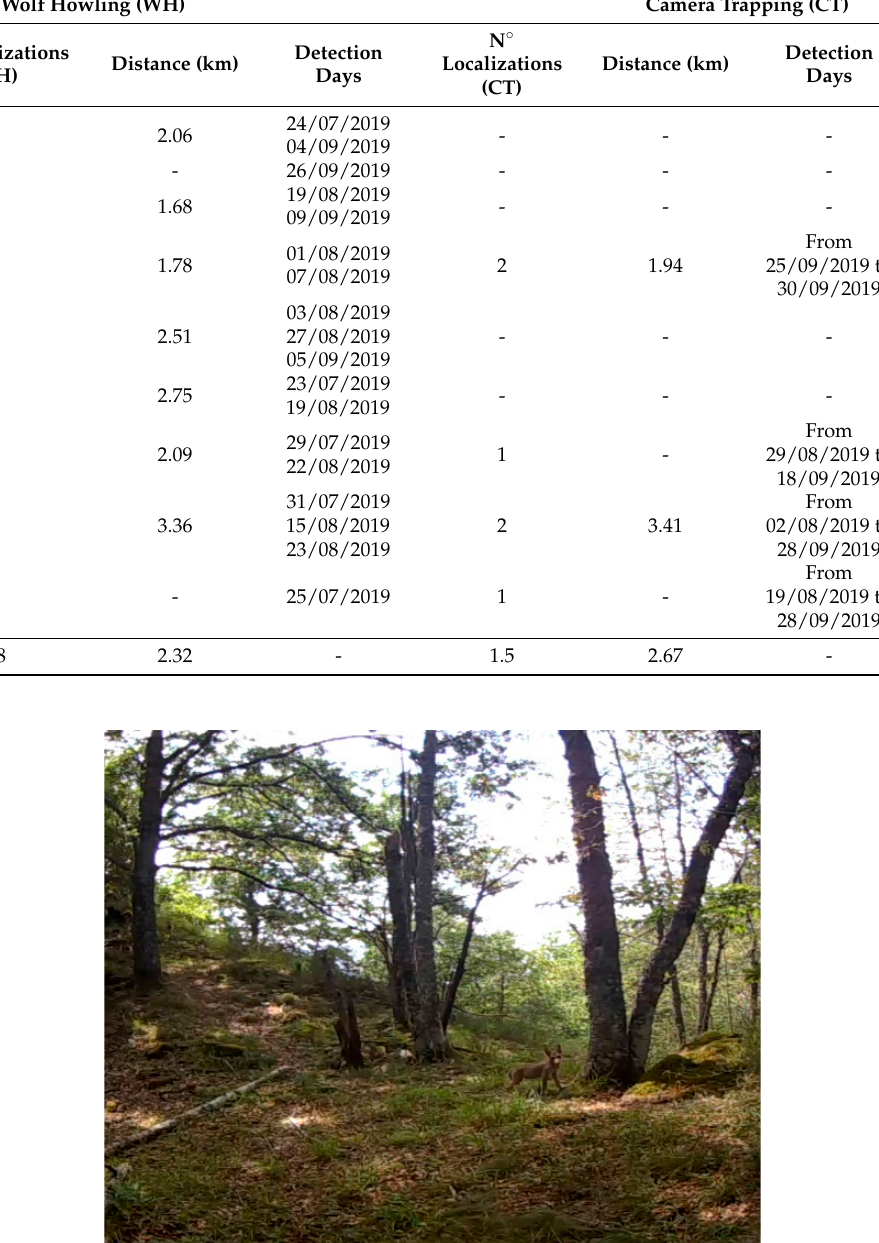
Figure 3. Rendez-vous site of TR pack. This picture was taken when this pack was still localised only on one site. In a few weeks, the reproductive female (Figure 5c) would have been seen with puppies in another area, 3.4 km from this place. For a few days, the litter was seen simultaneously split in two places.